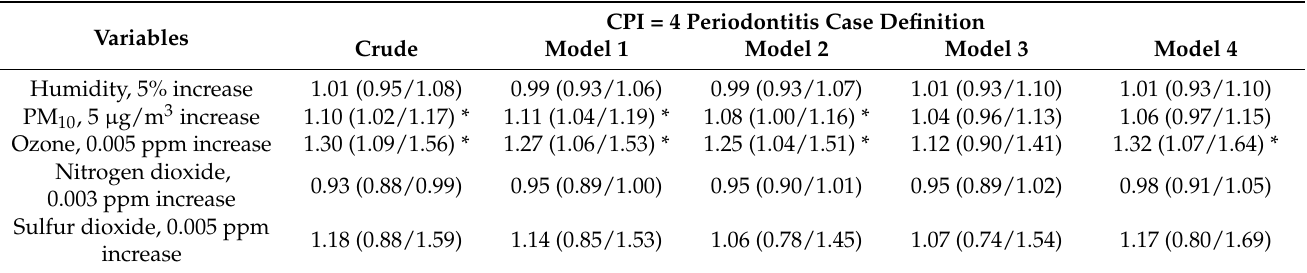
Table 3. Crude and adjusted ORs (95% CI) for the association between periodontitis (CPI = 4) and multiple air pollution